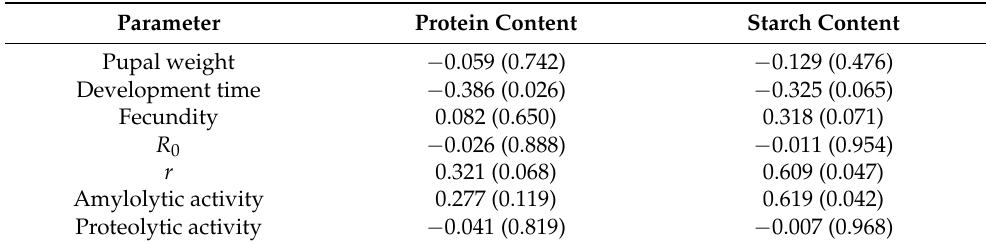
Table 5. Correlation coefficients ( r ) between life table parameters or digestive enzyme activities of Spodoptera littoralis and biochemical traits of various legume